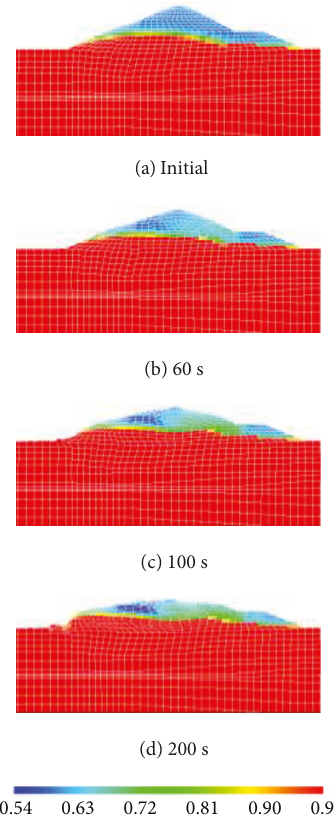
Figure 27: Distribution of suction (unit: kPa).